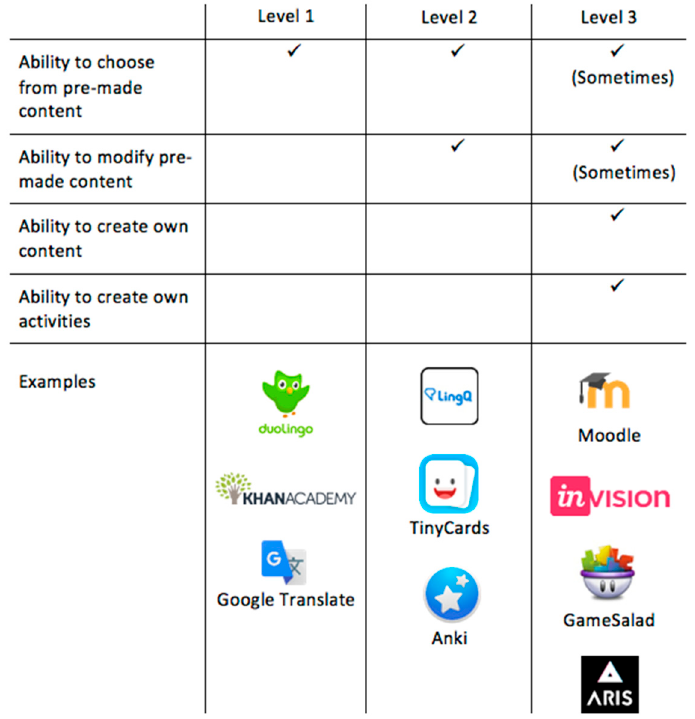
Figure 2. Levels of teacher involvement in mobile-assisted language learning (MALL) material creation and adaptation.